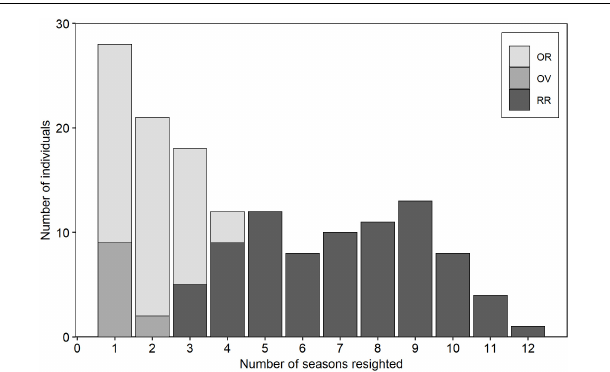
FIGURE 2 | Frequency of individual resightings of bottlenose dolphins off the Alvarado Lagoon between May 2006 through August 2010 ( n = 146 distinct adult dolphins). RR = regular residents, OR = occasional residents, OV = occasional